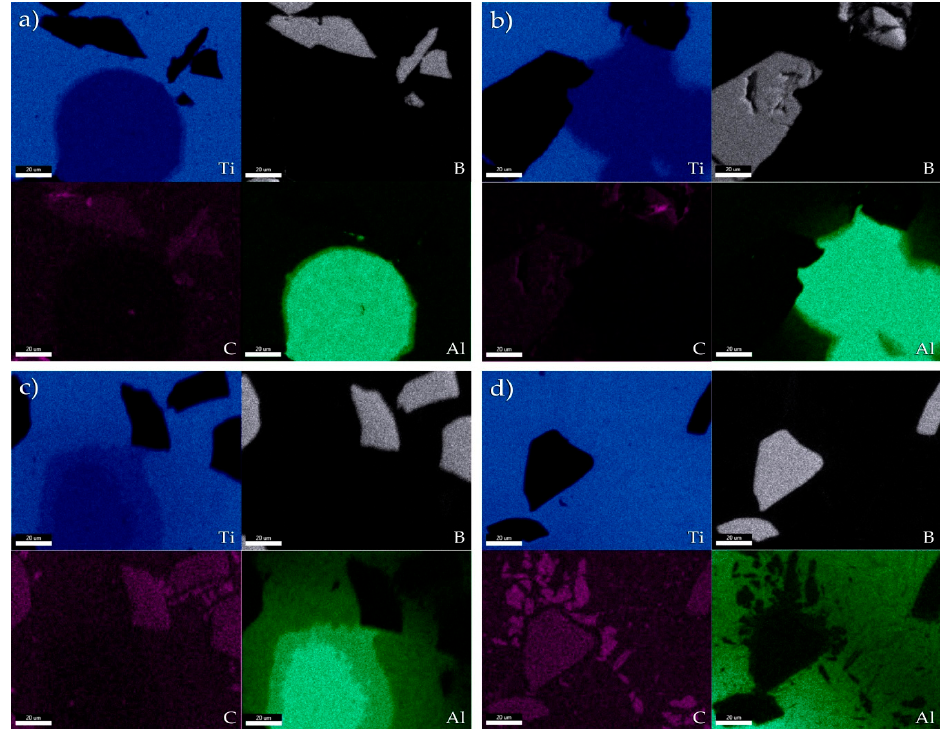
Figure 8. Mapping of the TMC processed by hot pressing for 5 min under 80 MPa, from the starting materials Ti matrix with TiAl* and B 4 C at the four processing temperatures: ( a ) 900 °C, ( b ) 1000 °C, ( c ) 1100 °C, and ( d ) 1200 °C.